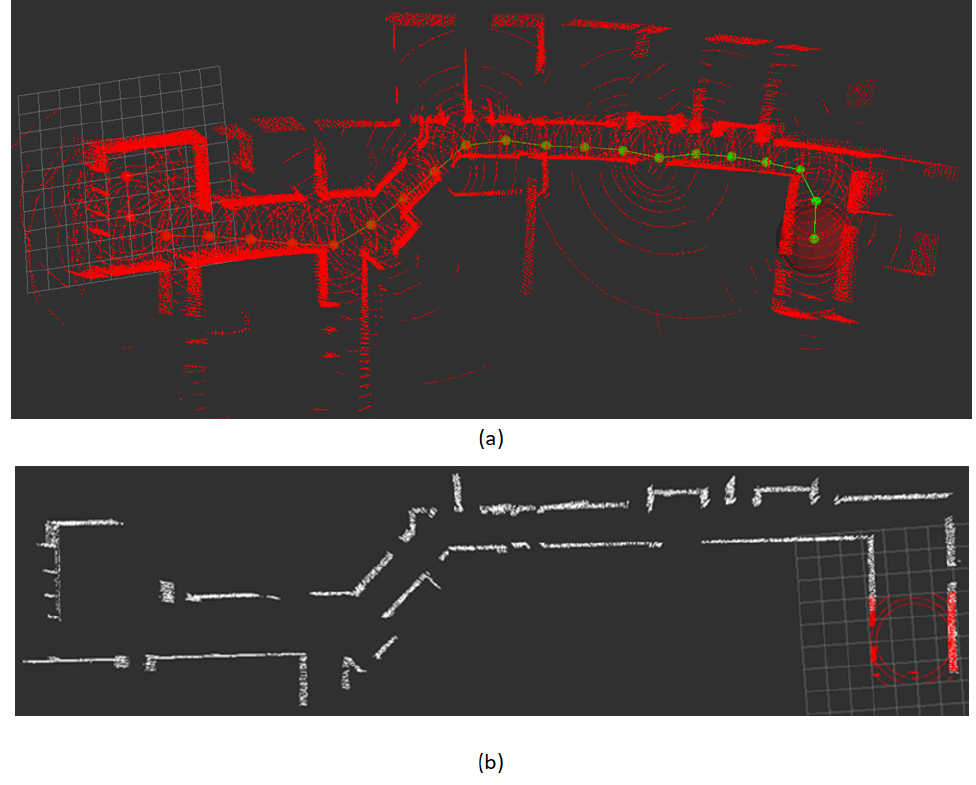
Figure 12. Final map obtained in simulation by ( a ) ROS’ hdl_graph_slam library–LiDAR’s detection range = 5 m; ( b ) eSoC-LAM running in the DE1-SoC platform–LiDAR’s detection range = 2